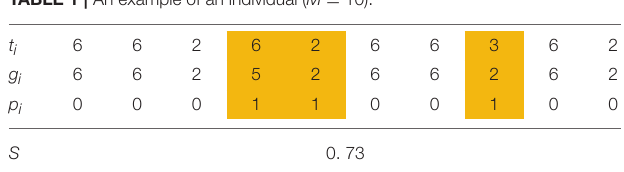
TABLE 1 | An example of an individual ( M = 10).